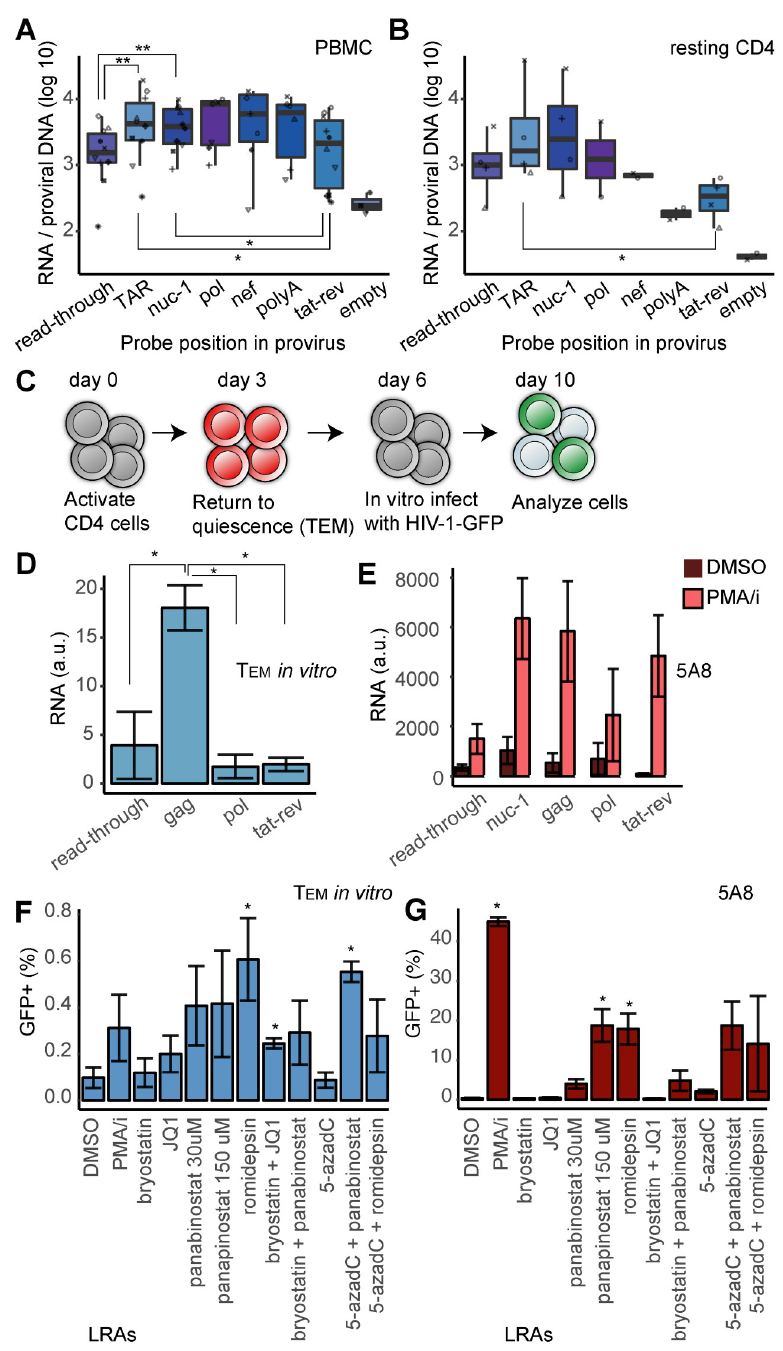
Fig 1. Transcripts in cells from HIV positive study participants and infection of primary T EM cells. ( A ) Box plot showing transcription levels in PBMCs from well-treated PLWH ( n = 10), at various positions of the provirus. Each study participant is represented by a unique symbol. The median signal is represented by the thick line and the box covers the 25 to 75 percentile of the values. P-values calculated by the Wilcoxon signed rank test. ( B ) Transcription levels in resting CD4+ T-cells from a subset of PBMCs in panel A ( n = 5), at various positions of the provirus. Each study participant is represented by a unique symbol. P-values calculated by the Wilcoxon rank sum test. ( C ) Schematic of the generation of HIV-1 T EM cells. ( D ) Transcription levels in primary T EM cells HIV-1 infected in vitro ( n = 4 ). ( E ) Transcription levels of HIV-1 in J-lat 5A8 cells after T-cell activation (PMA/i) or mock-treated (DMSO) ( n = 5 ). ( F ) HIV-1 latency reversal in T EM cells after 24h exposure to a panel of putative latency reversal agents. ( G ) HIV-1 latency reversal in J-lat 5A8 cells after 24h exposure to the panel of molecules. For panels (D), (F), (G) p-values were calculated by unpaired t-test, � p < 0.05, �� p < 0.01. https://doi.org/10.1371/journal.ppat.1008264.g001 PLOS Pathogens| https://doi.org/10.1371/journal.ppat.1008264 January30,